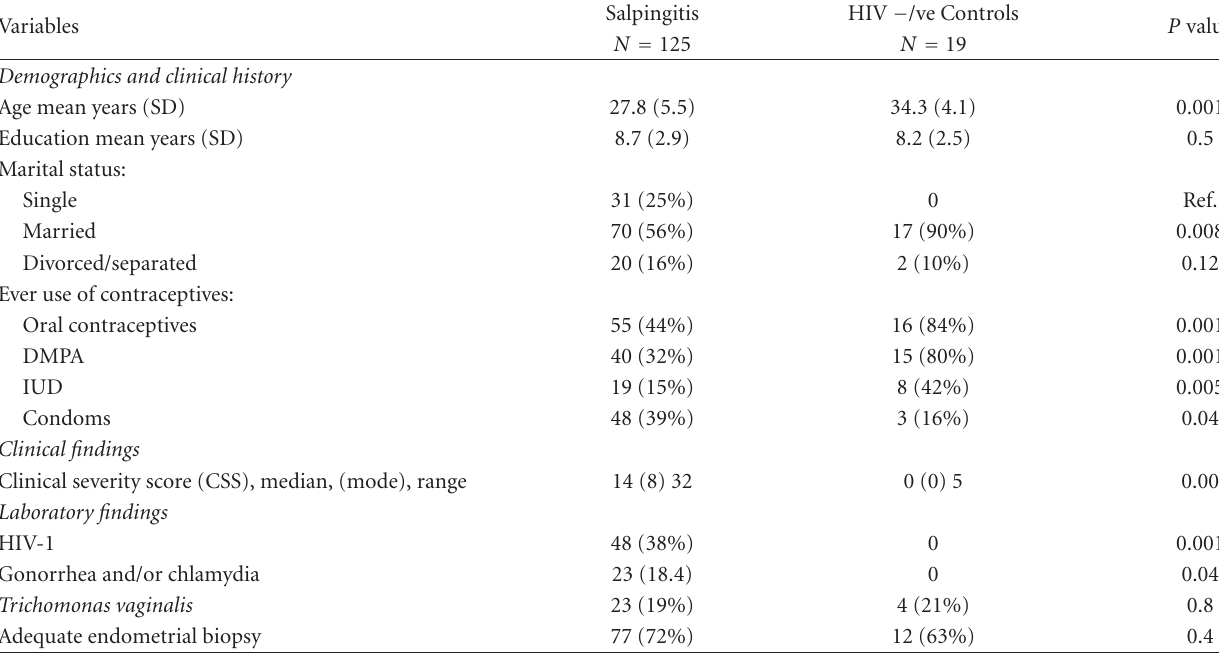
Table 1: Comparison of demographic, clinical history and signs, and laboratory findings for women laparoscopically diagnosed with salpingitis and women undergoing tubal ligation